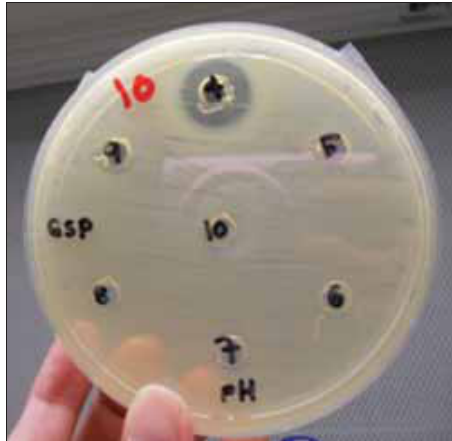
Figure-2: Clear inhibition zone of bacteriocin against Aeromonas hydrophila.